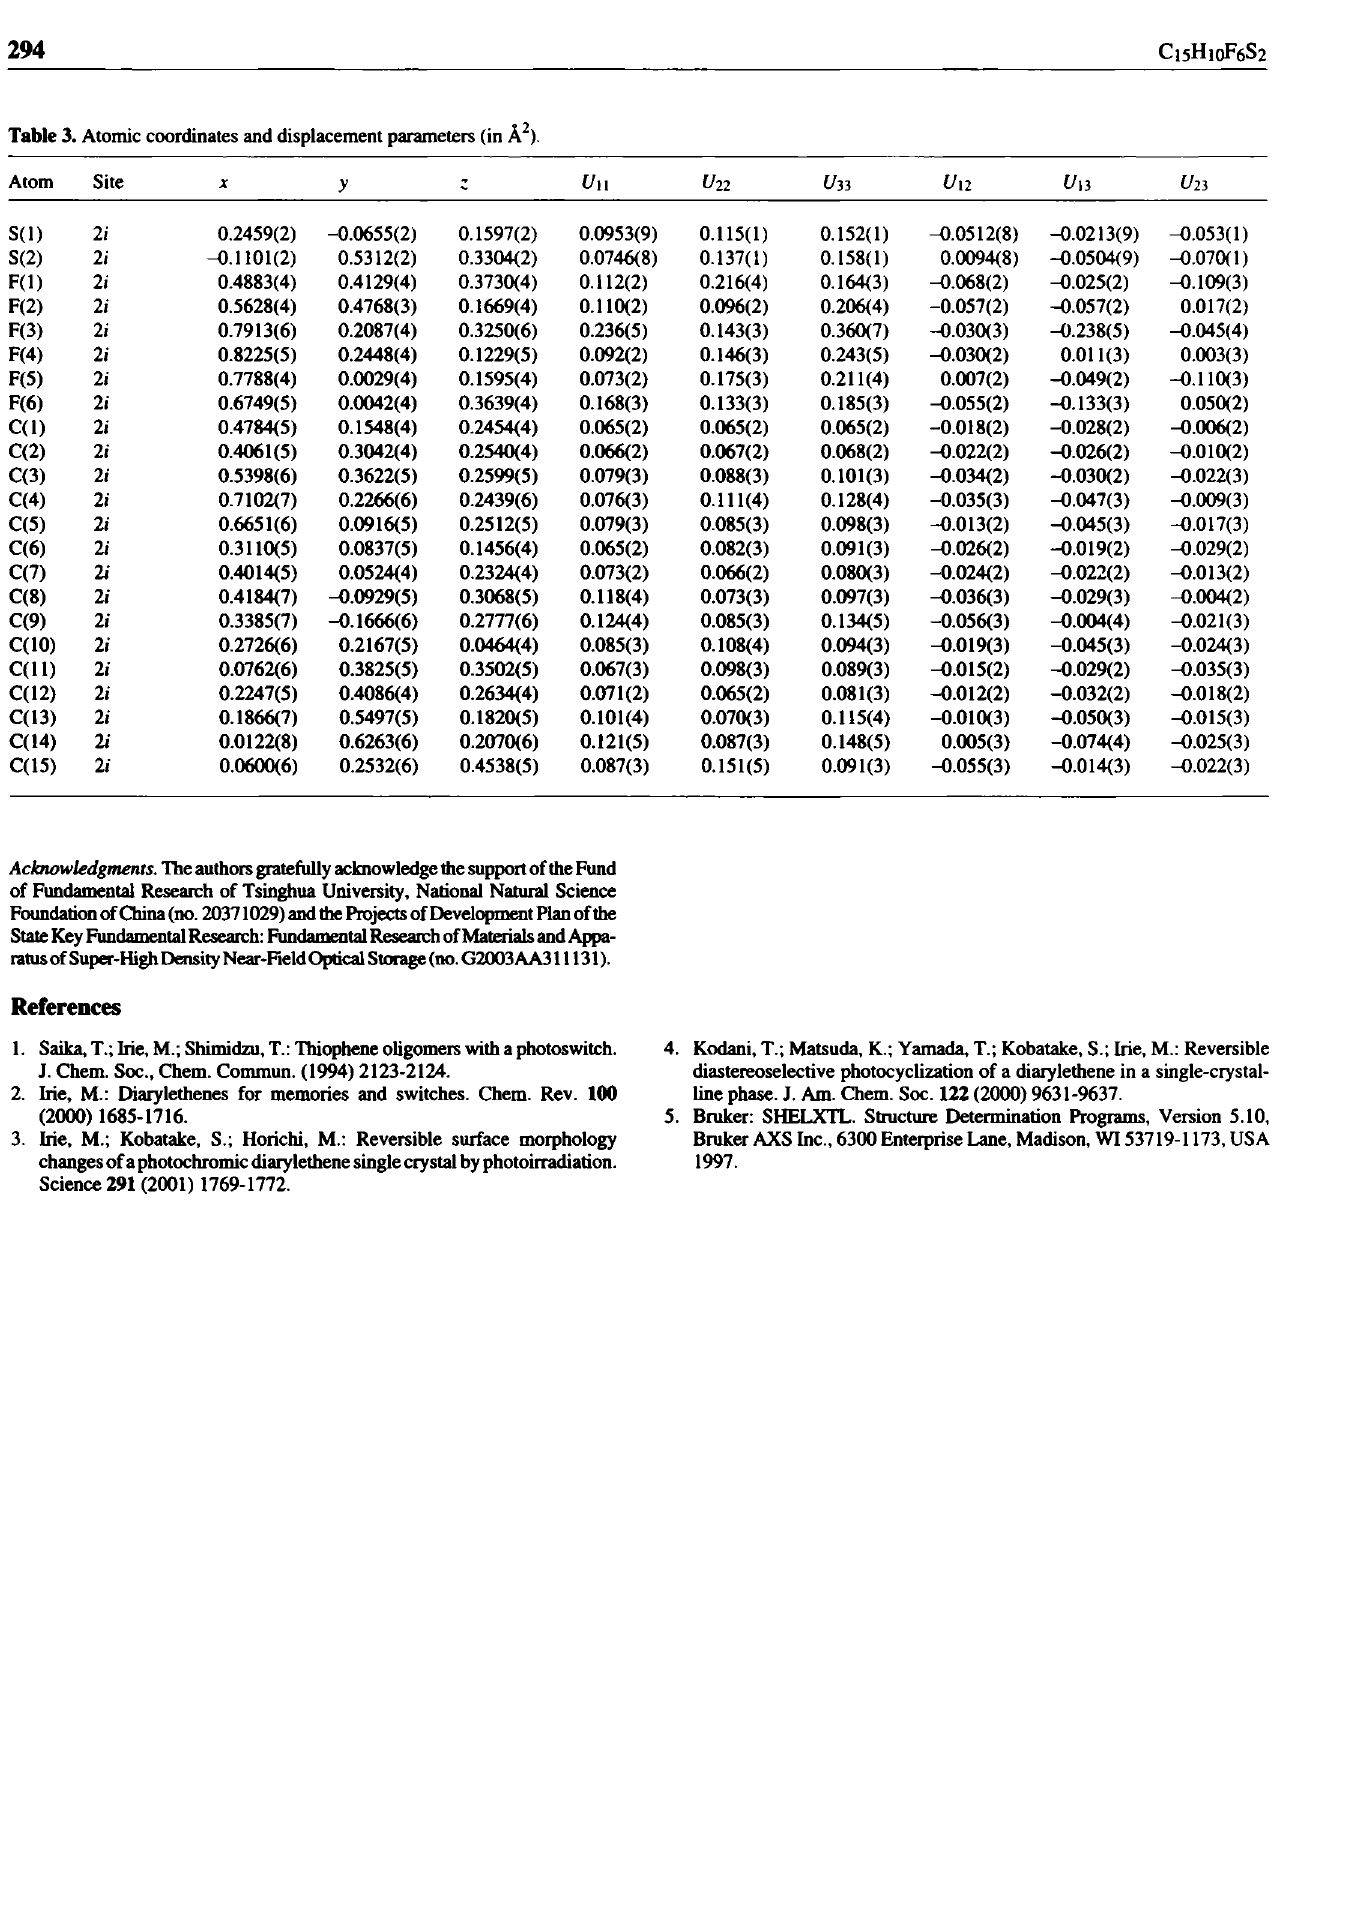
Table 3. Atomic coordinates and displacement parameters (in Â 2